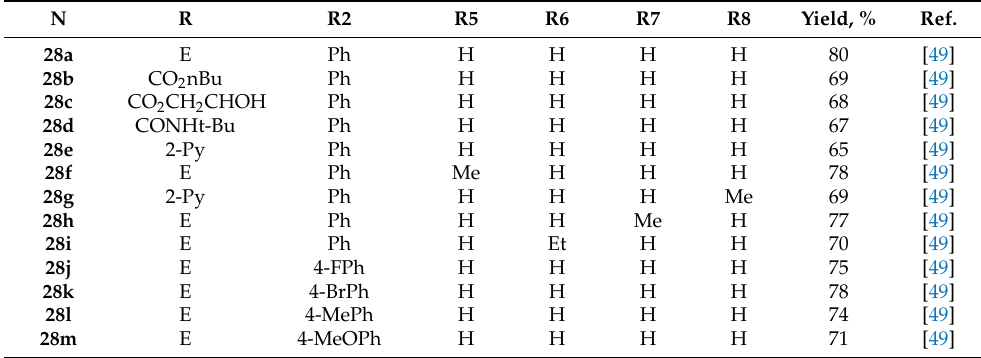
Table 5. Substituents and yields of oxidative cycloaddition of alkenes to indolizines (Scheme 12).